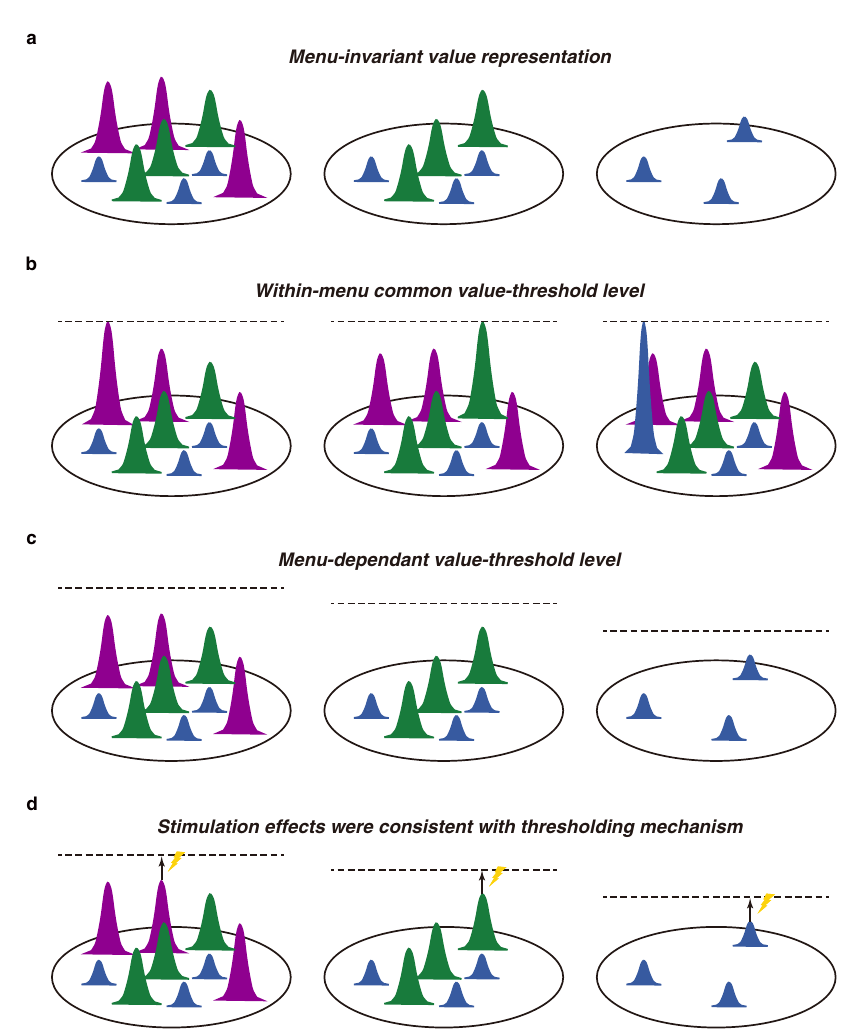
Fig. 8 Four fi ndings in the SC support for thresholding mechanisms in value-based decision making. The Gaussian curves represent late fi xation population activities on the SC map associated with the highest (purple), middle (green), and lowest (blue) valued targets in the visual array. The dashed line represents the value-threshold level. a The value of targets was represented across the SC in an absolute manner that did not vary as the menu decreased from 3-values remaining (left) to 2-values remaining (middle) to 1-value remaining (right). b Within a given menu, neuronal activity associated with the selected option reached the same value-threshold level regardless of whether the highest (left), middle (middle), or lowest (right) valued target was chosen. c The value-threshold levels systematically decreased as the menu changed from 3-values remaining (left), 2-values remaining (middle), and 1-value remaining (right). d Stimulation effect was a function of the distance between absolute value representations and value-threshold